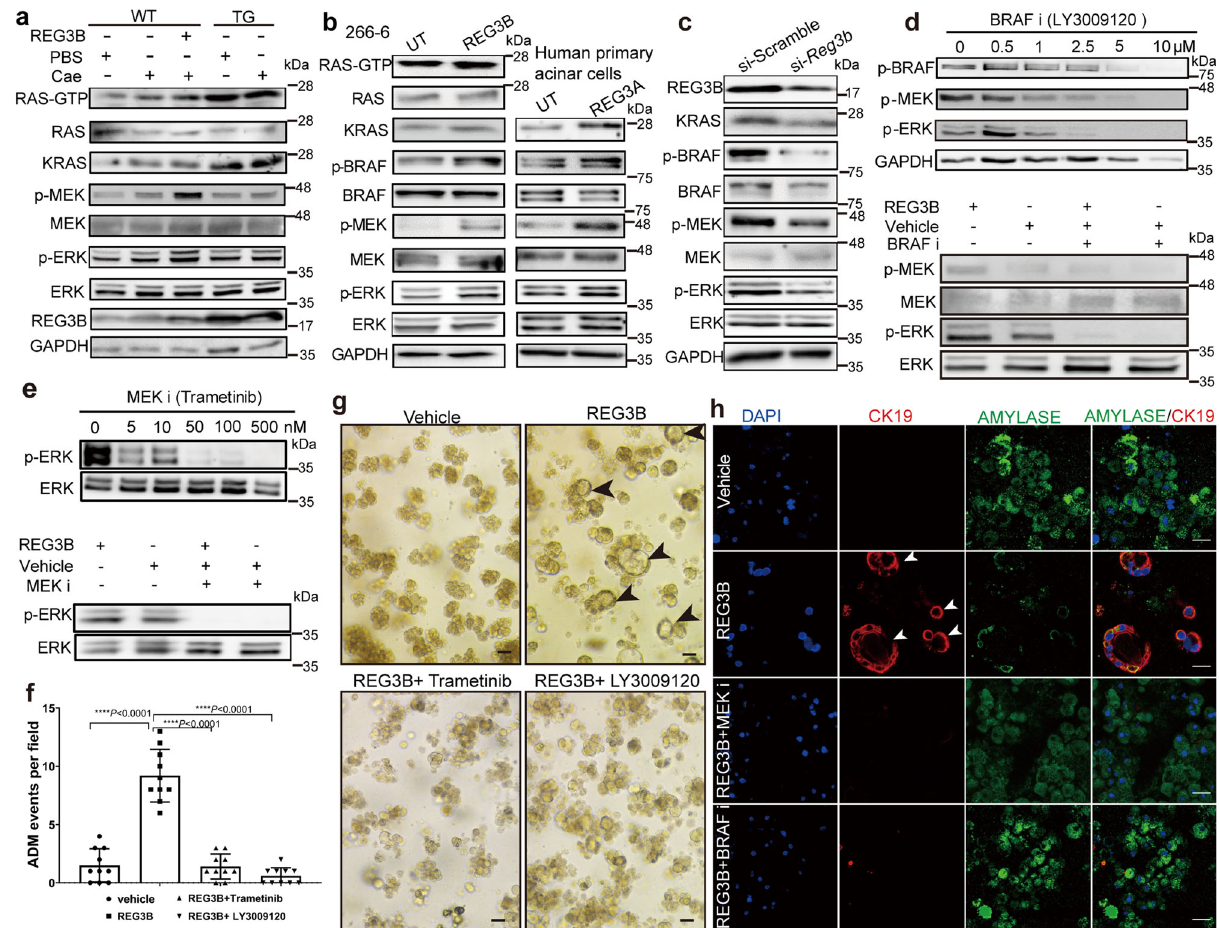
Fig. 5 REG3B induces ADM through the RAS-RAF-MEK-ERK signaling pathway. a Western blot showing increased expression of p-ERK, p-MEK, p-BRAF, KRAS, and active RAS in the pancreatic tissue of REG3B-treated WT mice with caerulein-induced pancreatitis (WT cae + REG3B) and a moderate increase in TG mice with caerulein-induced pancreatitis (TG cae) ( n = 3, one-way ANOVA). b Western blots demonstrating increased expression of p-ERK, p-MEK, 48 h ( n = 3, student ’ s t -test). c Western blot showing the reduced expression of phosphorylated ERK, MEK, BRAF, and total KRAS in the 266-6 cell